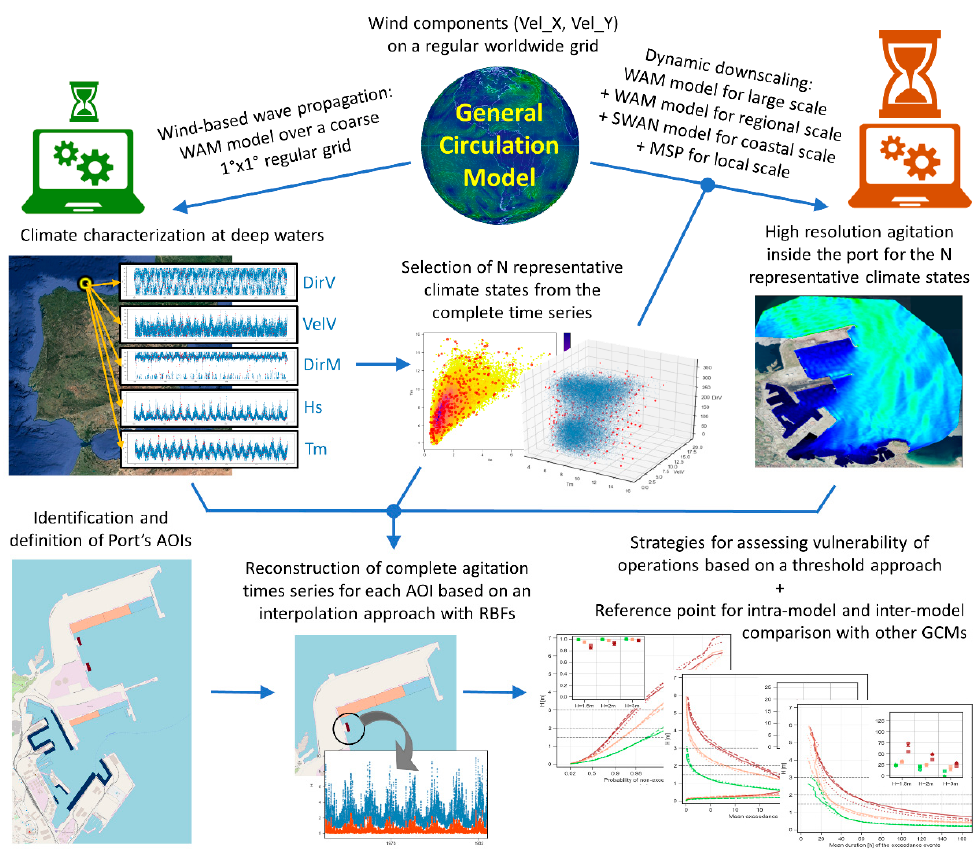
Figure 1. Scheme of the different stages of the methodology for assessing the vulnerability of operations inside a port using, as main input, wind components from a GCM.